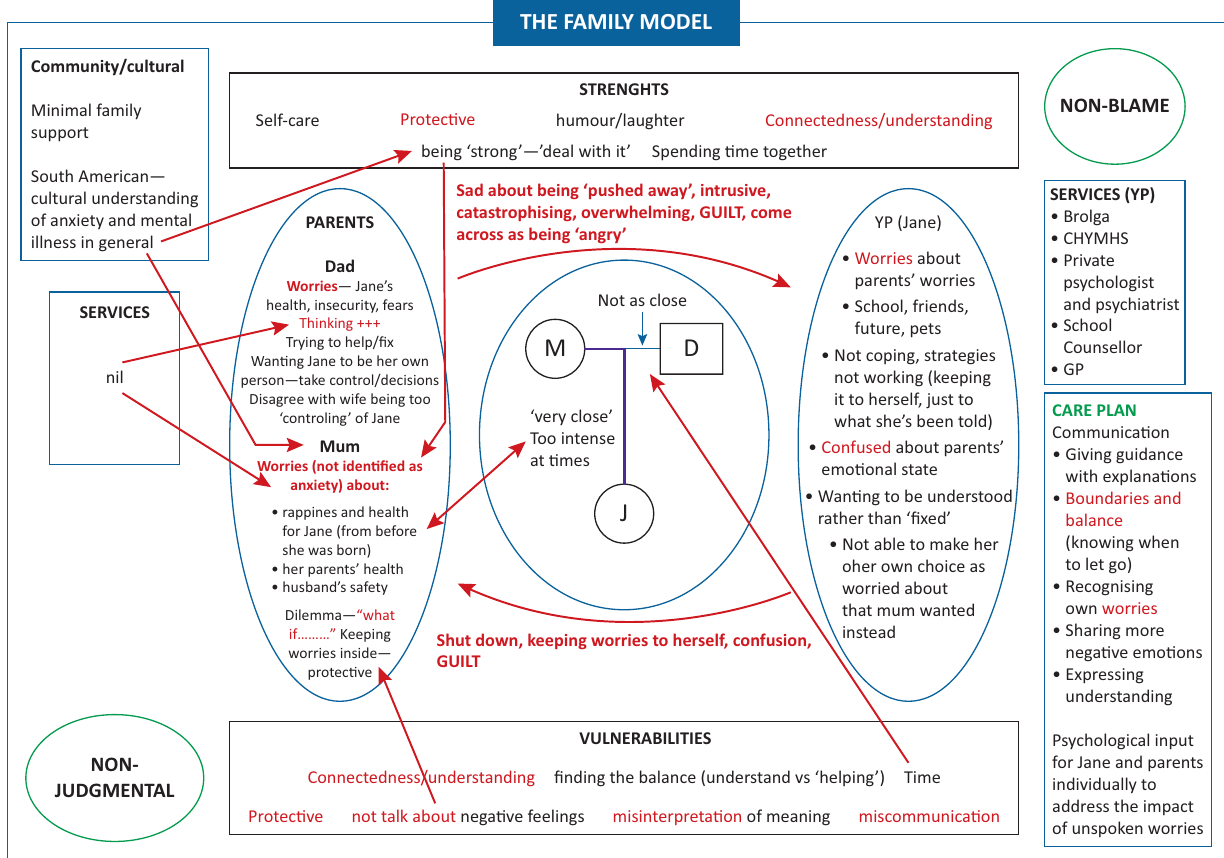
Figure 3. Specialist Adolescent Inpatient